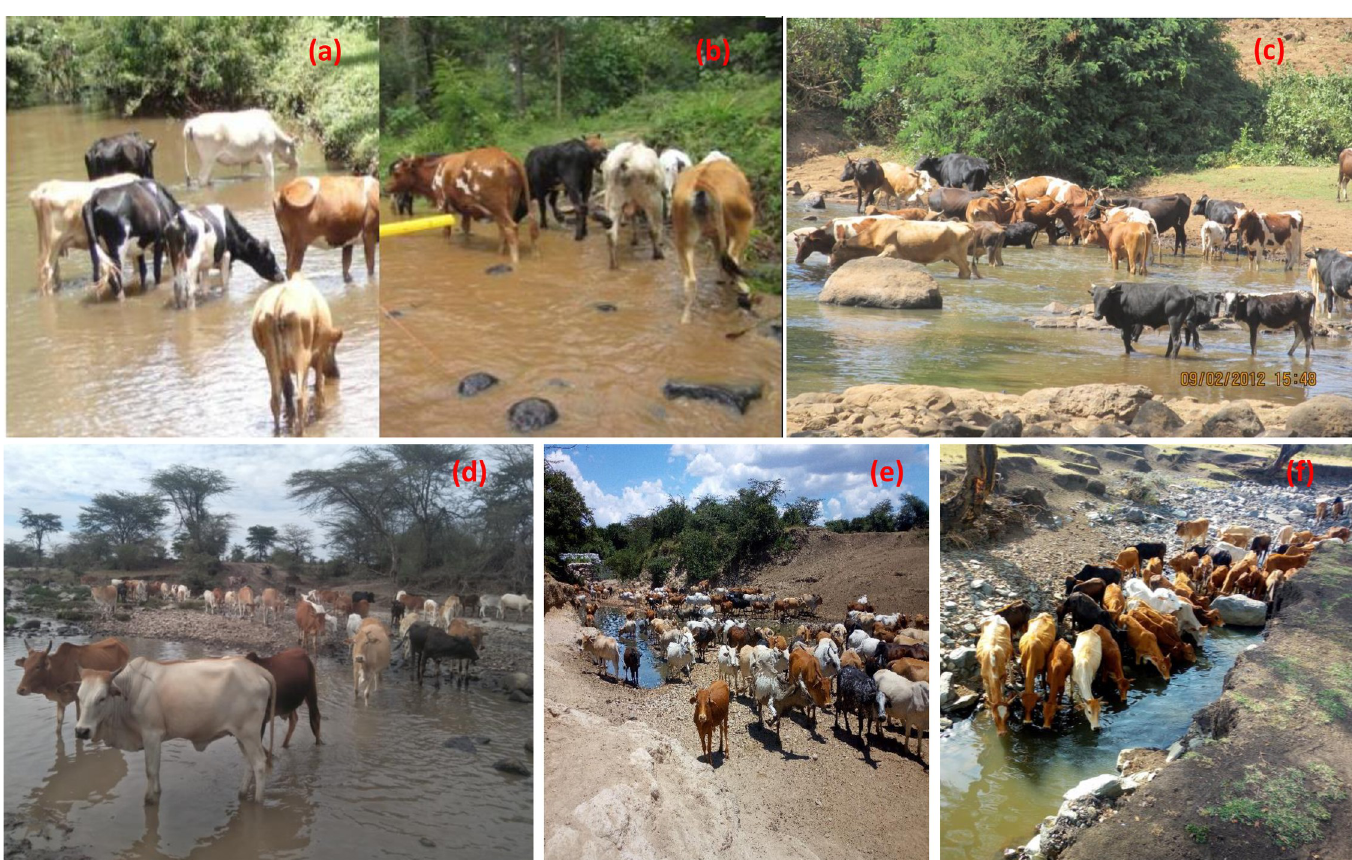
Fig 2. Livestock watering points during monitoring of behaviour in the upper Mara River Basin (a, b and c) and lower basin in the Talek Region (d, e and f) during the wet (a, b and c) and dry (c, e and f)